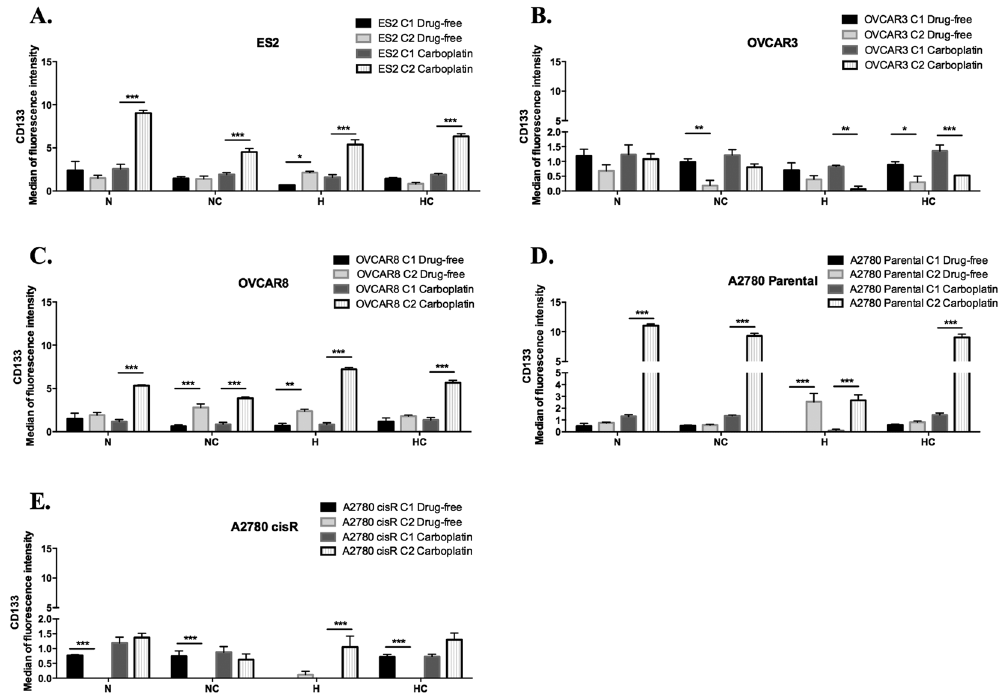
Figure 6. In ES2, OVCAR8 and A2780 cancer stem CD133 + cells command resistance to hypoxia and carboplatin. CD133 expression levels in a drug-free environment and upon carboplatin exposure for ( A ) ES2 cells, ( B ) OVCAR3 cells, ( C ) OVCAR8 cells, ( D ) A2780 parental cells and ( E ) A2780 cisR cells in the first and in the second cycles of treatments. N – Normoxia; NC – Normoxia supplemented with cysteine; H – Hypoxia; HC – Hypoxia supplemented with cysteine. Results are shown as mean ± SD. Asterisks represent statistical significance among the first and the second cycle within the same treatment. * p < 0.05, ** p < 0.01, *** p < 0.001 (One-way ANOVA with post hoc Tukey